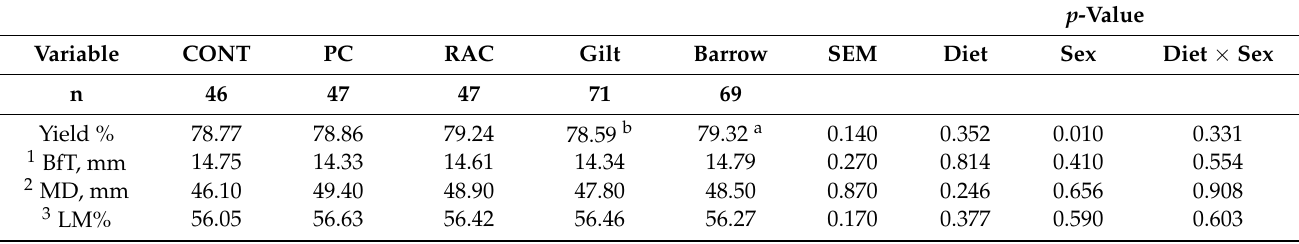
Table 3. Effects of treatments on carcass characteristics.